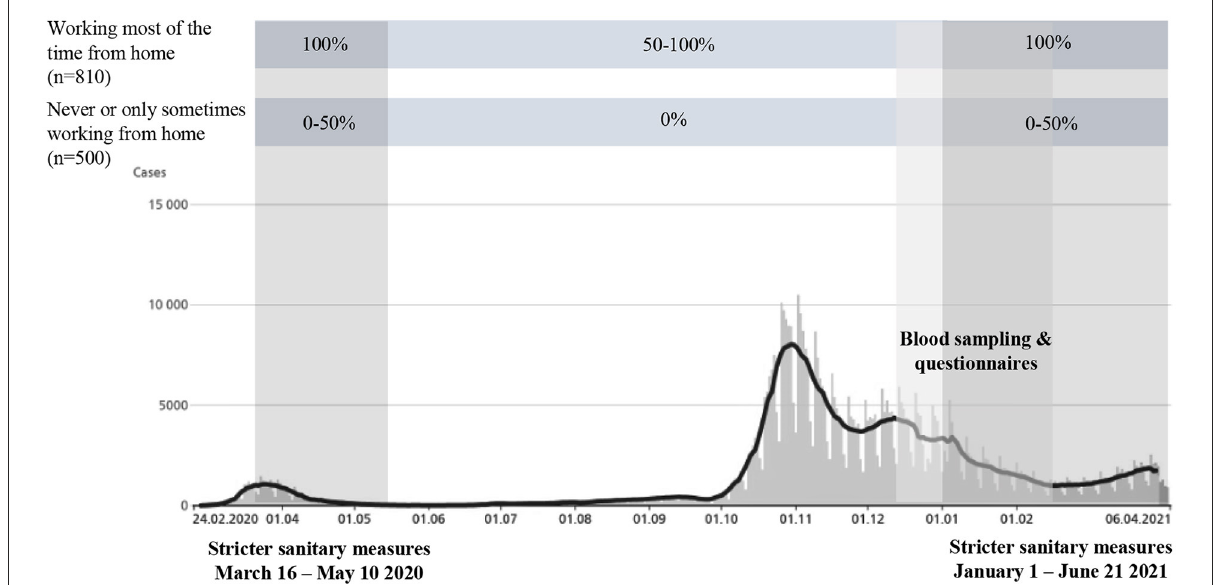
FIGURE1 Time percentage of work from home among employees in the Nestlé company classified into two exposure groups ( working most of the time from home and never or only sometimes working from home ) over time and in relation to the COVID-19 pandemic and the Corona Immunitas Nestlé study. The graph shows the laboratory-confirmed cases in Switzerland from 24.02.2020 to 06.04.2021, in absolute case numbers. It is important to note that the number of tests performed has increased over time, since only hospitalized at-risk persons were tested in the beginning of the pandemic (34). n = number of employees invited to participate in the study. Figure adapted from Schmid et al.